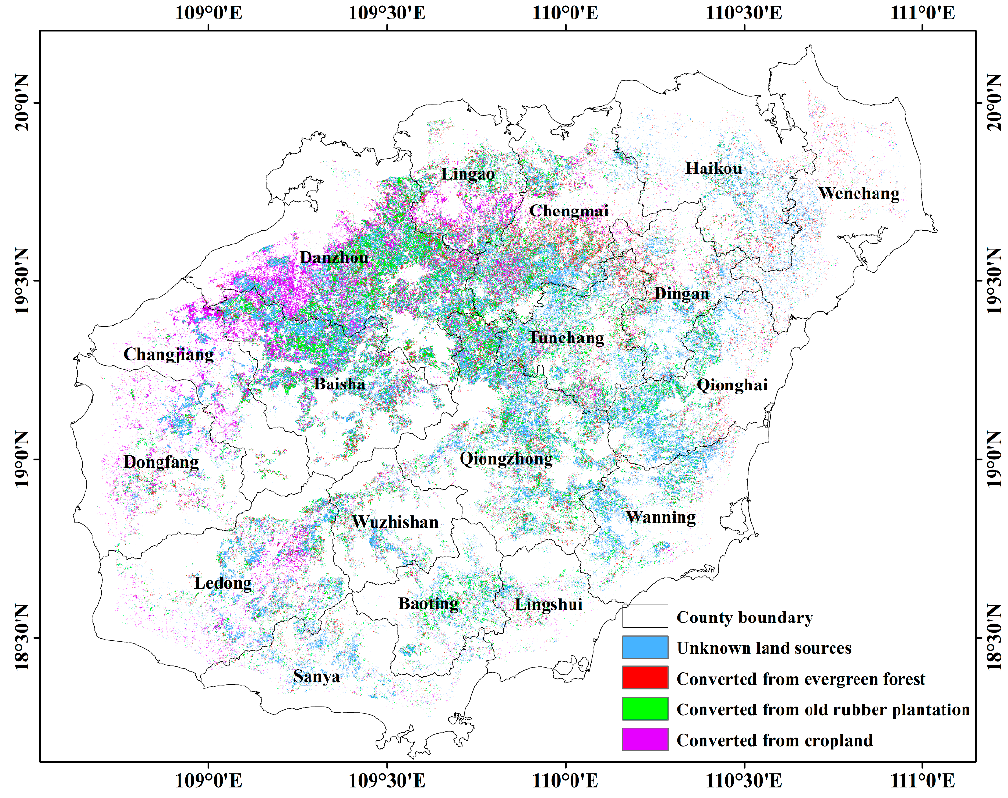
Figure 10. Spatial distribution of land sources of rubber plantations on Hainan Island.